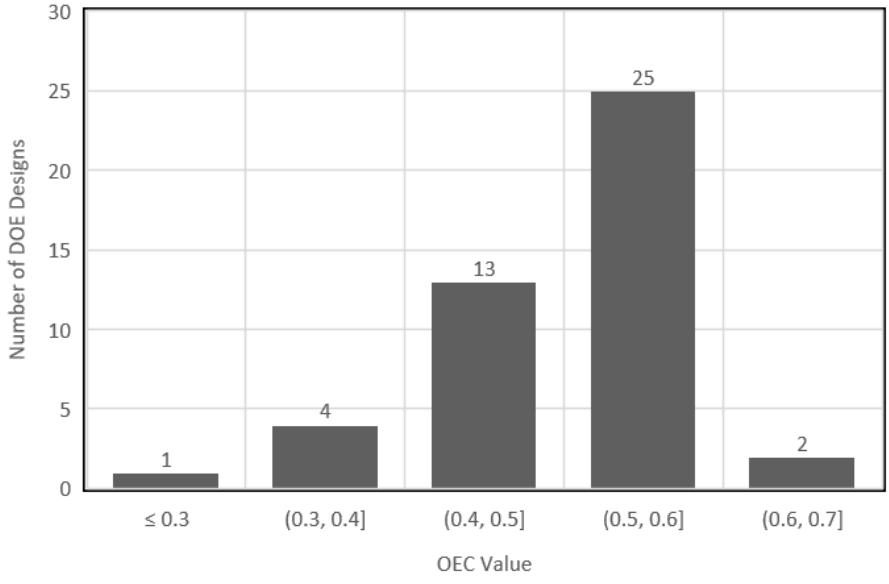
Figure 11. OEC histogram for the alternative designs from DOE.